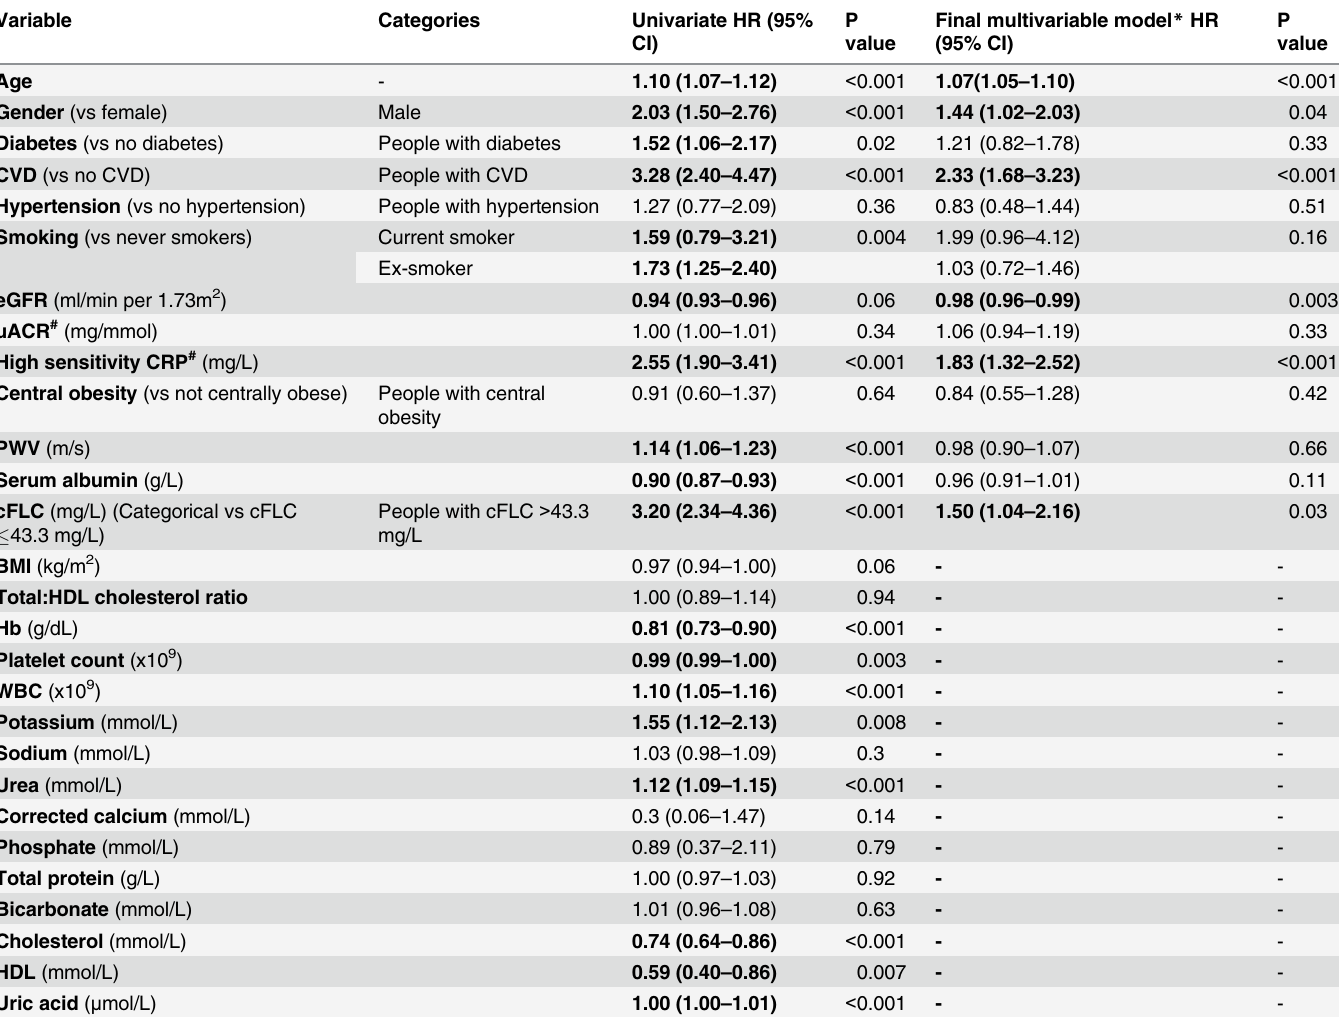
Table 5. Univariate and multivariable Cox proportional hazards analyses showing determinants of all-cause